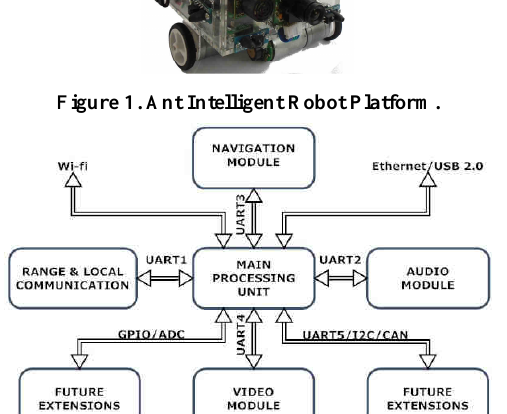
Figure 1. Ant Intelligent Robot Platform.